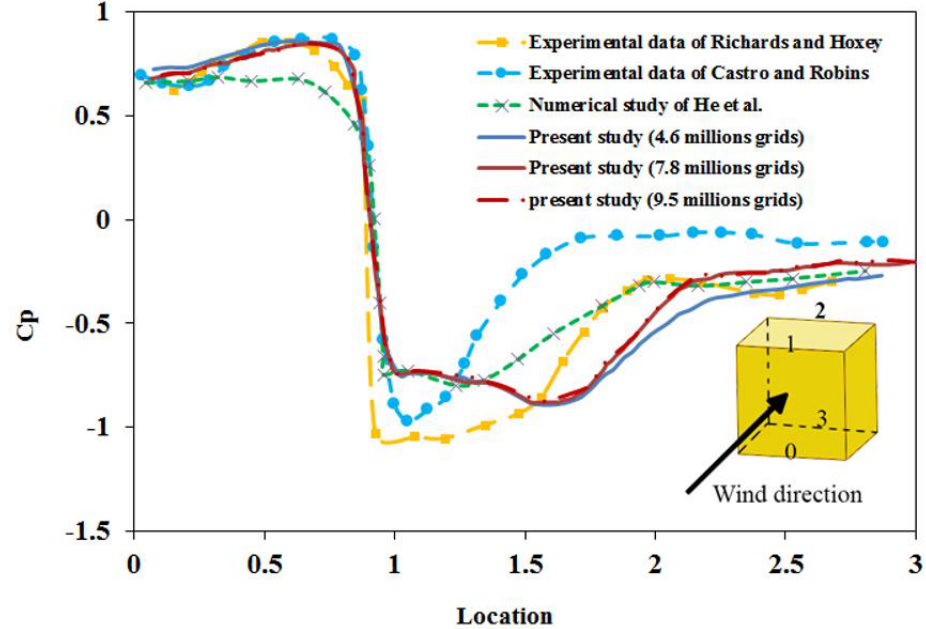
Figure 2. Comparison of the mean pressure coefficient for the experimental studies of [64,74], numerical simulation of [75], and three different grids number for the presented study.